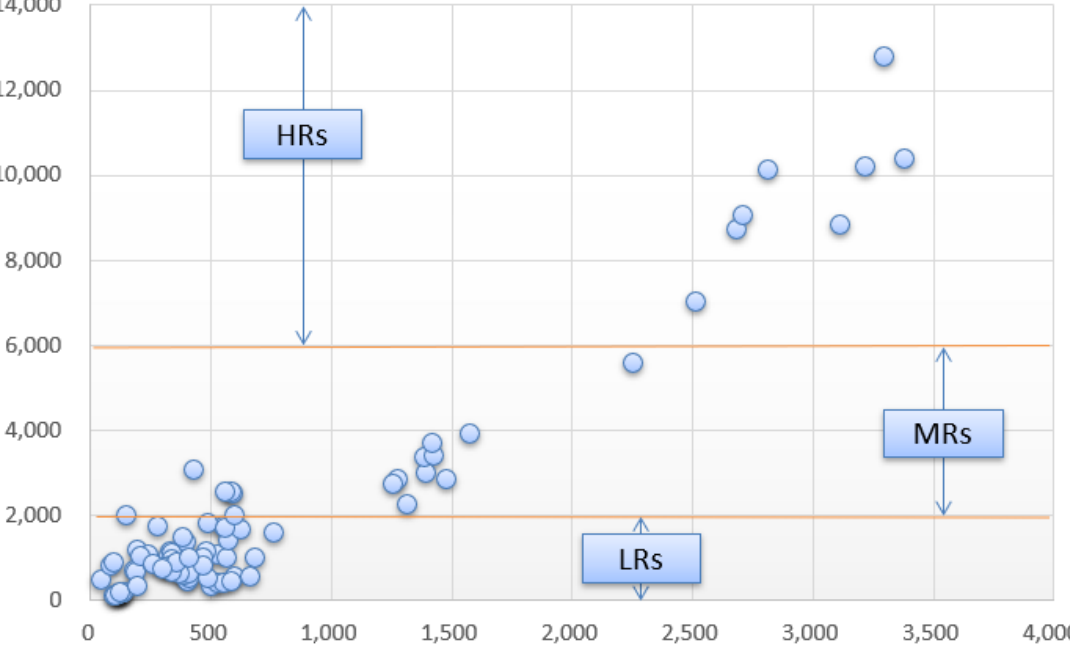
Figure 2. Annual sale revenue and CO2 emissions of all of the DMUs.